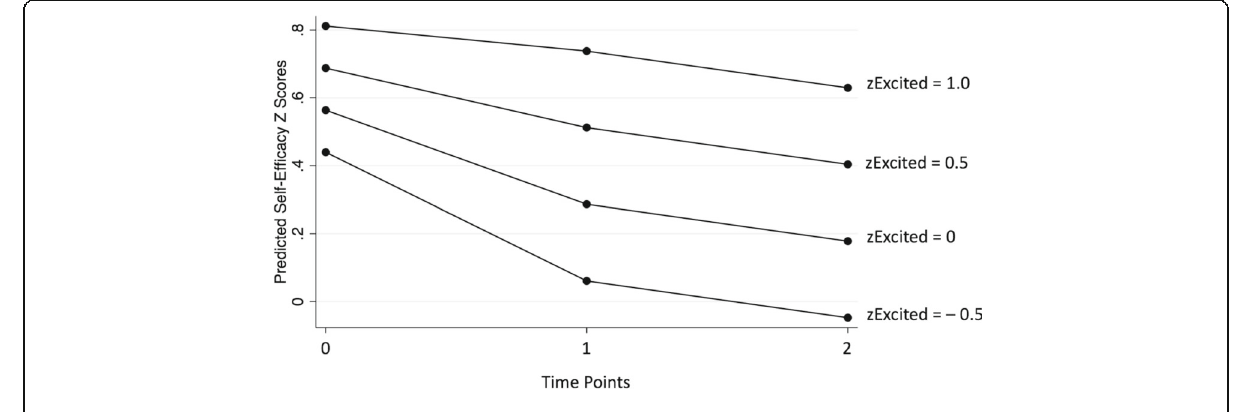
Fig. 1 Moderation effect of excitement on self-efficacy trajectories